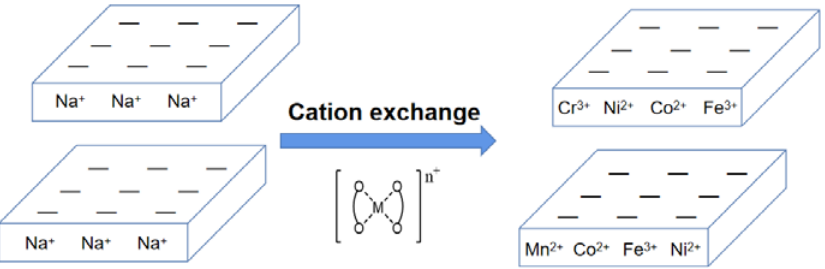
Figure 2. The interaction of the catechol chromium complex and bentonite via cation exchange (M = Cr, Mn, Fe, Co, Ni, Cu, Zn).